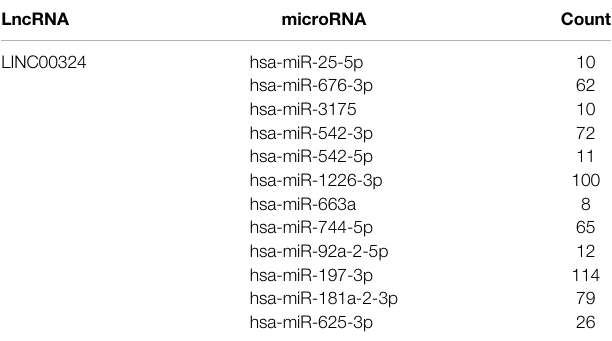
TABLE 2 | Predicted LncRNA-miRNA interactions. miRNA-target interactions were analyzed for the 27 lncRNA using large-scale CLIP-Seq